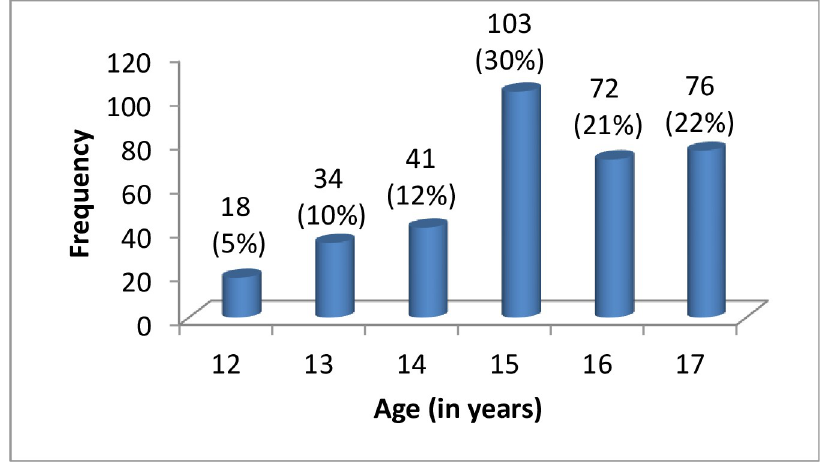
Fig 1. Age distribution of Adolescents in Mekelle city, Tigrai Regional State, Ethiopia, 2019 (N = 344).